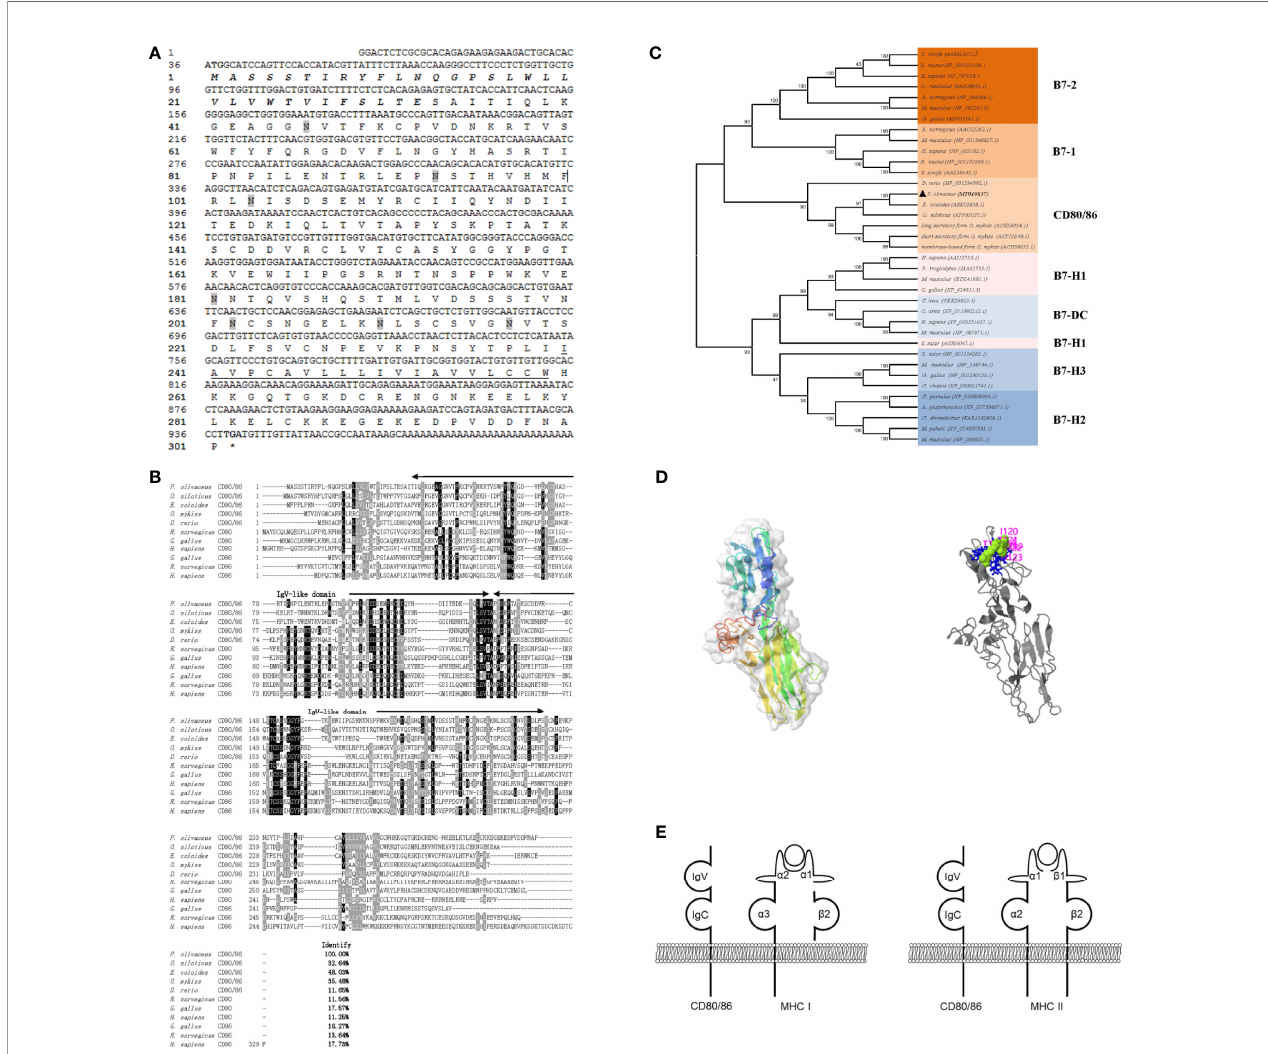
FIGURE 1 | Sequence analysis. (A) The sequence of CD80/86 cDNA and deduced amino acid in fl ounder. The signal peptide and transmembrane domain are in bold italic and underlined, respectively. The N-linked glycosylation sites were shadowed, and the start codon and stop codon are bolded. (B) Multiple alignments of CD80/86 protein homologs. The residues that are ≥ 75% identical among the aligned sequences are in black. The dashes in the amino acid sequences indicate gaps introduced to maximize alignment. (C) Phylogenetic trees of B7 superfamily. The unrooted phylogenetic trees are constructed by the neighbor-joining method based on the amino acid alignment (Clustal W) of full-length protein sequences. Numbers in each branch indicate the percentage bootstrap values on 1,000 replicates. The accession numbers were shown behind the species name. (D) The prediction of the tertiary structure of CD80/86 and the potential binding site. (E) Schematic representation of the distribution pattern of CD80/86 and MHC